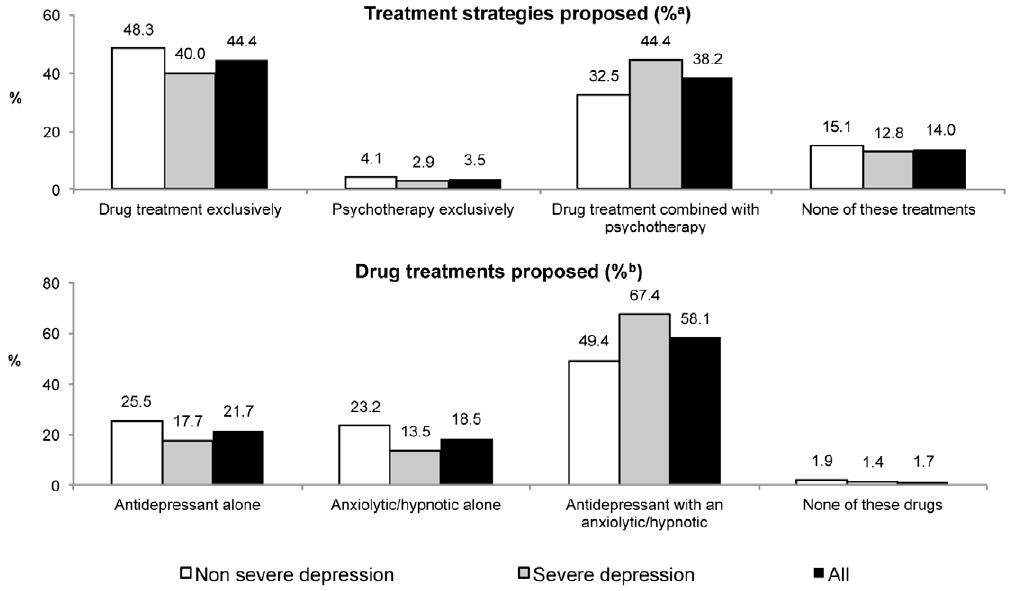
Figure 2. GPs’ treatment choices according to major depression severity (Weighted data). a Calculated among GPs managing the patient themselves without any specialist’s advice and GPs who would take advice on the diagnosis before managing the patient b Calculated among GPs recommending a drug treatment.